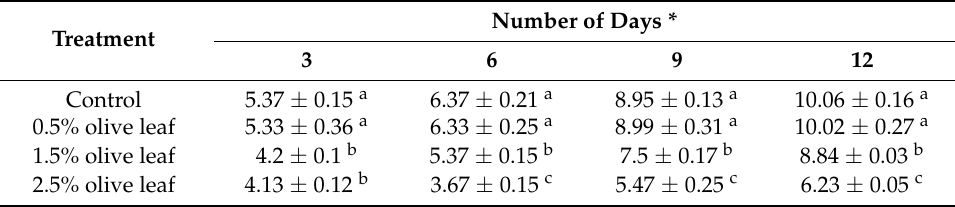
Table 3. Effect of the olive leaf extract on total count bacteria (log CFU/g) of the sheep meat slides stored at 5 ◦ C for 12